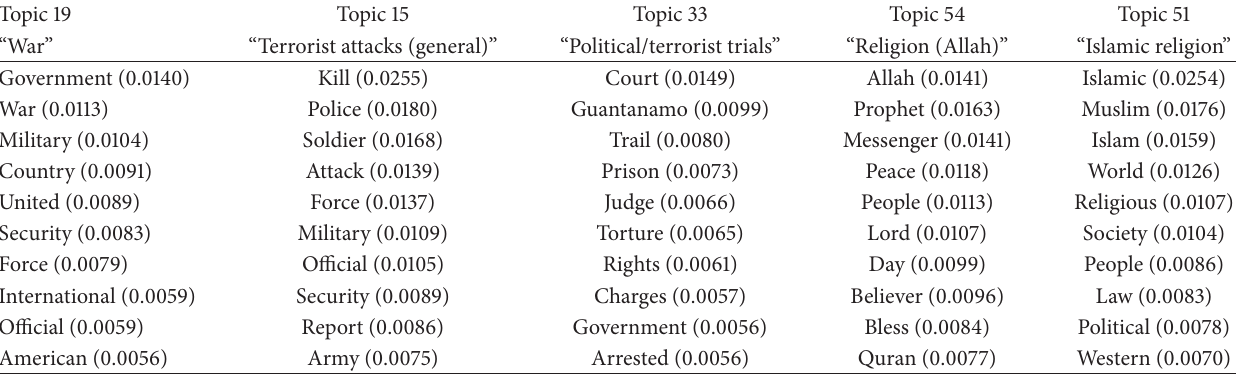
Table 1: Ten most relevant words with their respective conditional probabilities for the five most relevant topics for all data from the IslamicAwakening